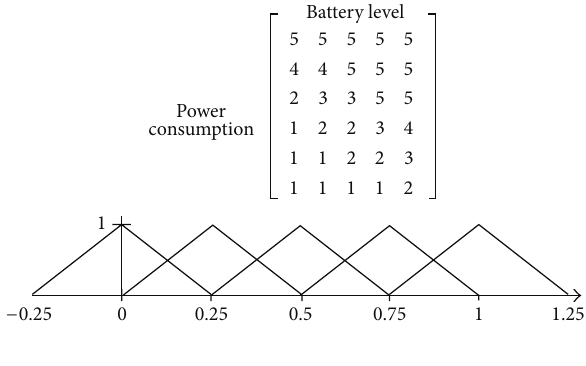
Figure 8: Inference engine and consequent membership functions for battery power and consumption are used for both wake-up and tracking resource allocation.